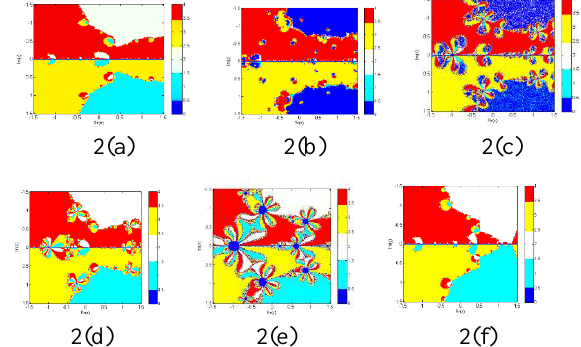
MS3, KM, CM and JM) respectively for non-linear function